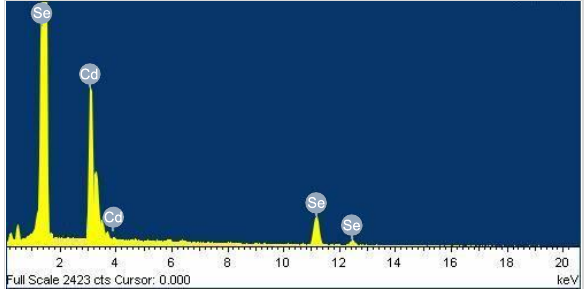
Figure 8: EDAX pattern of PVA-capped CdSe quantum dots synthe- sized by the reaction of 2 × 10 − 3 mol dm − 3 Cd(AcO) 2 with 4 × 10 − 3 mol dm − 3 Na 2 SeSO 3 , in the presence of 9.2% PVA, at 48 °C.